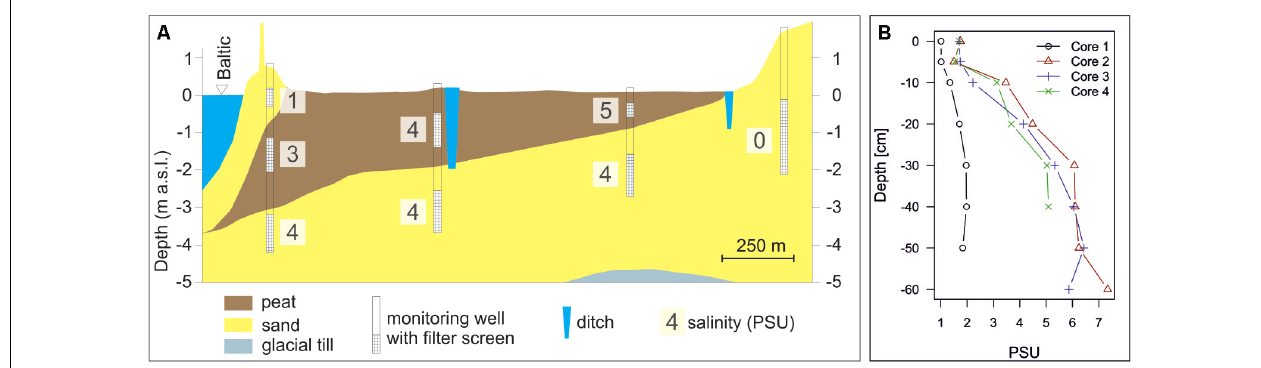
FIGURE 7 | (A) Geological profile through the peatland with salinity distribution (PSU); (B) Depth distribution of salinity derived from pore water sampling along a transect from the forest (Core 1) to close behind the dune dyke (Core 4) (see Figure 3 ). All cores but the one near the forest edge show increasing salinities with depth within the